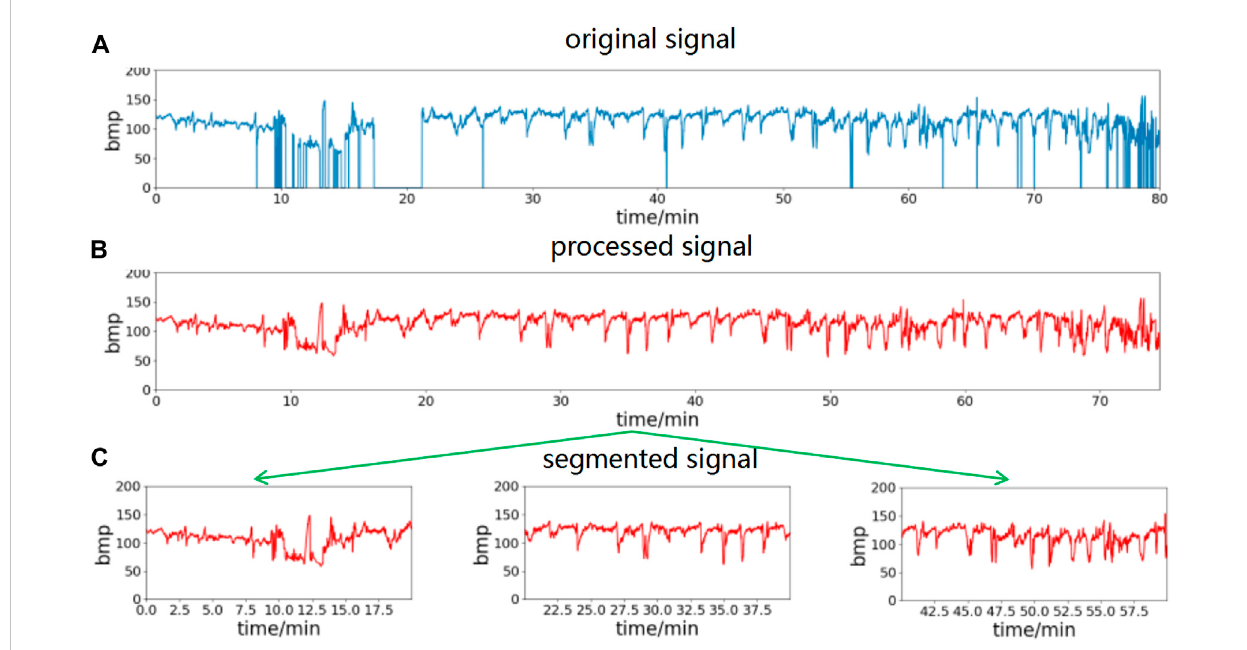
FIGURE 2 FHR signal preprocessing process. Remove spikes and missing values of the original signal, then divide into segments of 20-min length. (A) The original signal, (B) processed signal, (C) segmented signal.